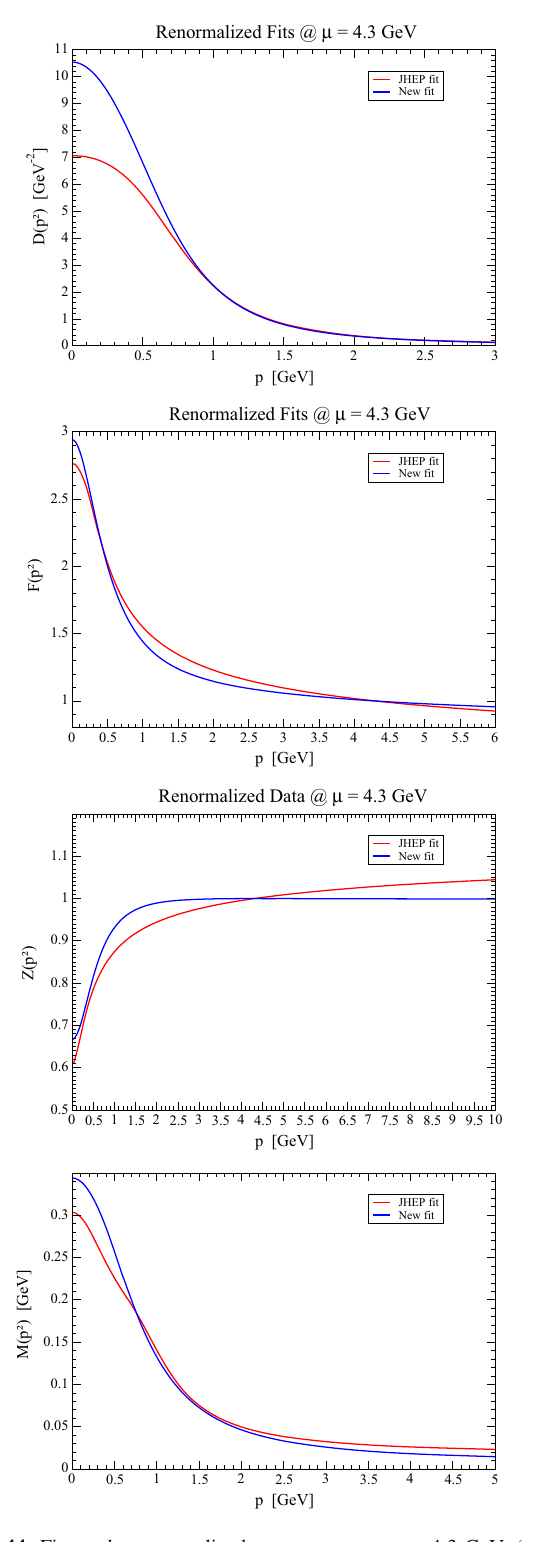
Fig. 44 Fits to the renormalized propagators at μ = 4 . 3 GeV: (top- left) pure Yang–Mills gluon propagator; (top-right) pure-Yang–Mills ghost dressing function; (bottom-left) quark wave function; (bottom- right) running quark